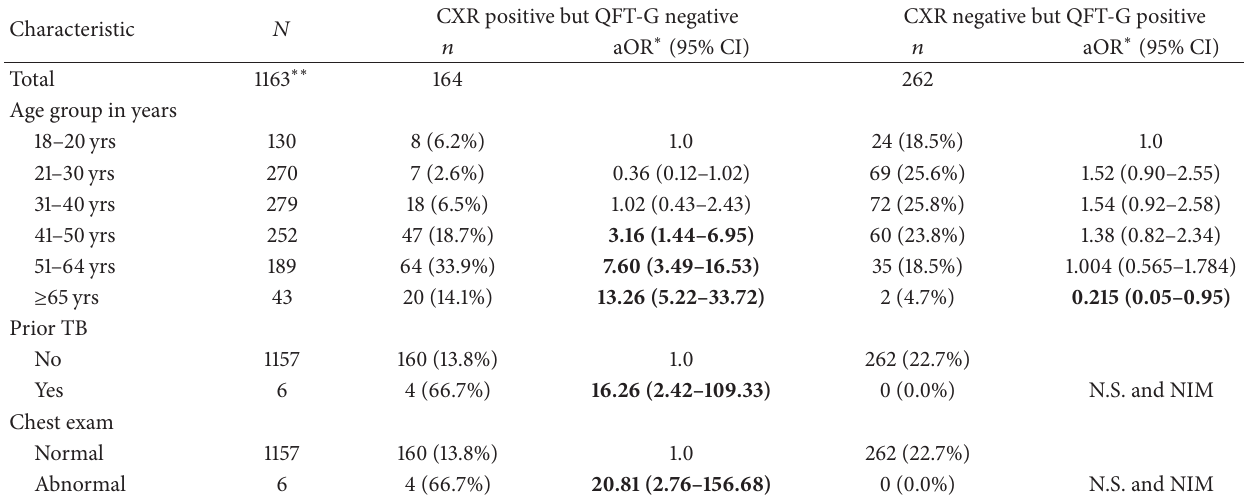
Table 7: Subject characteristics associated with CXR and QFT-G